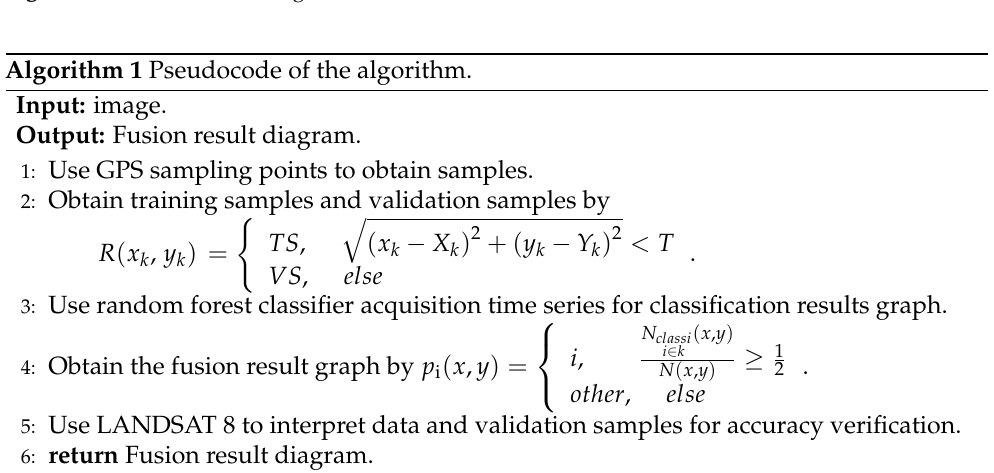
Figure 5. Flow chart of the algorithm.